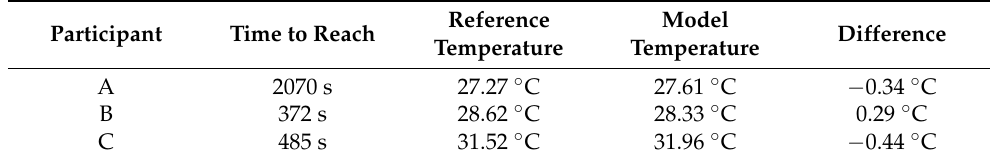
Table 5. Model results for sensation change